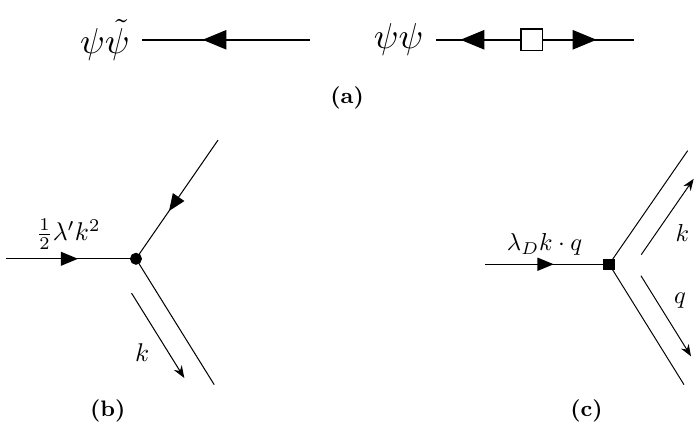
Figure 1. Feynman rules of the diffusive field theory (model B). The vertex denoted by the solid circle is a non-linear interaction term, and the vertex denoted by a solid square is a new interaction generated by the field dependence of the diffusion